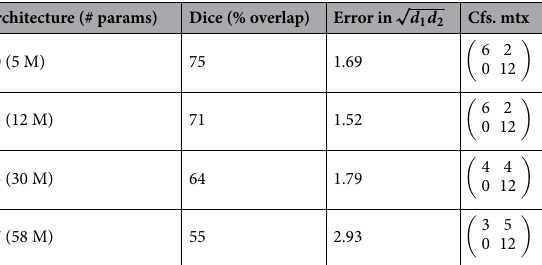
Architecture (# params)